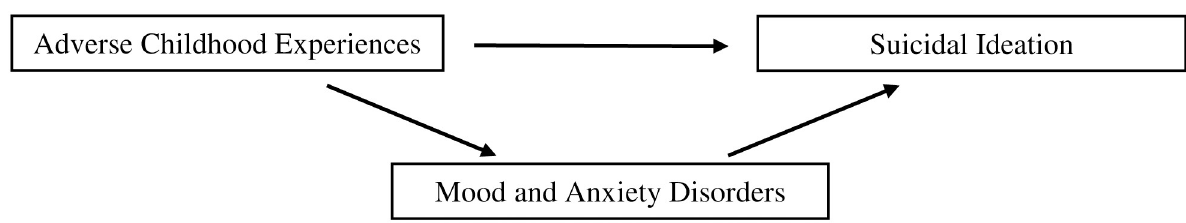
Fig 1. Association between suicidal ideation, mood and anxiety disorders, and adverse childhood